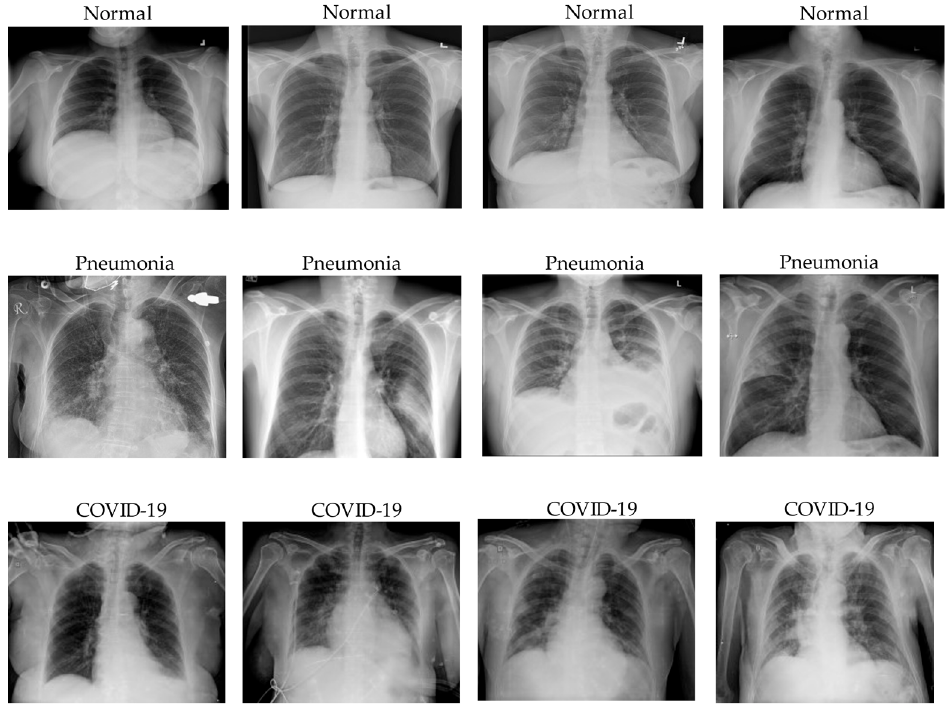
Figure 1. Image samples from the customized COVID-19 classification dataset with respect to Normal, Pneumonia, and COVID-19 classes.